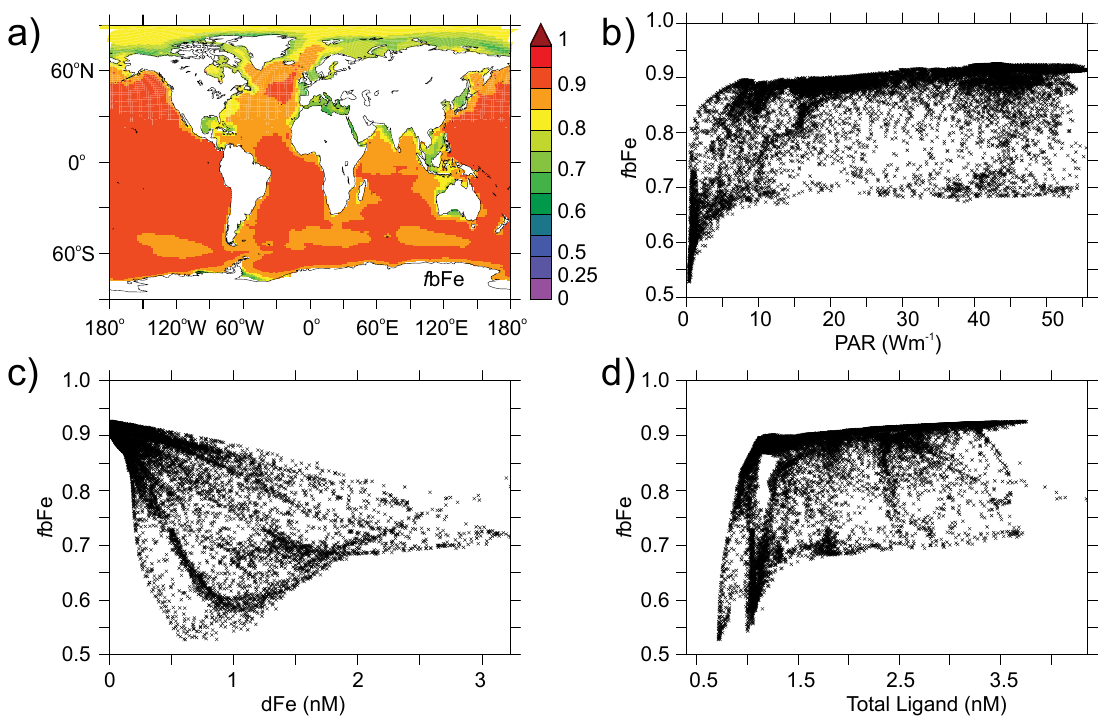
Fig. 4. The (a) annual maximum surface proportion of the dFe pool present as bFe and its relationship to (b) irradiance (Wm − 2 ) , (c) the total concentration of ligands (nM) and d) the dFe concentration (nM), when bFe is assumed to equal Fe(II) + Fe(III) + FeL S .